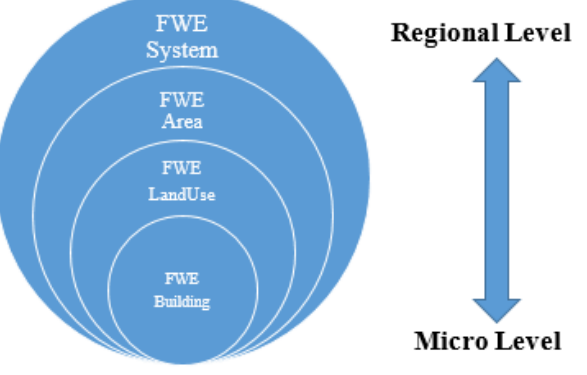
Figure 2. The FWE ADE conceptual diagram